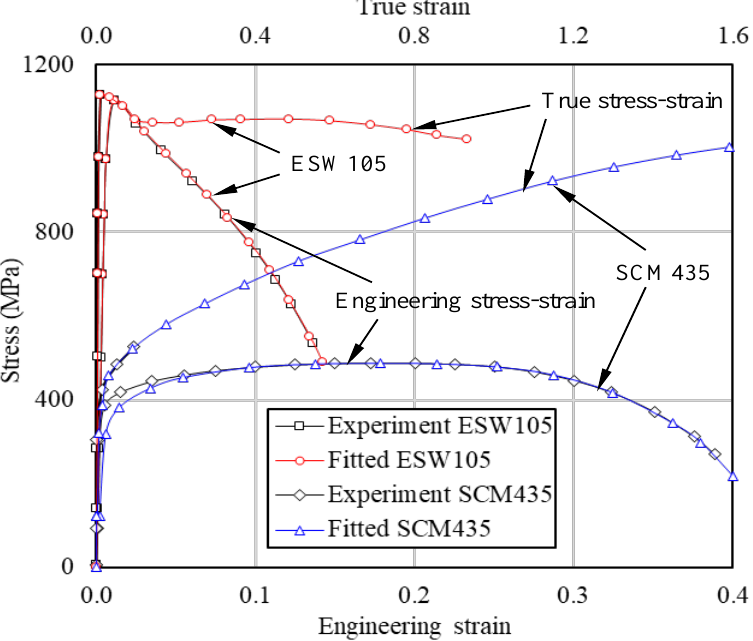
Figure 1. Engineering and true stress-strain curves of ESW105 and SCM435 [4].